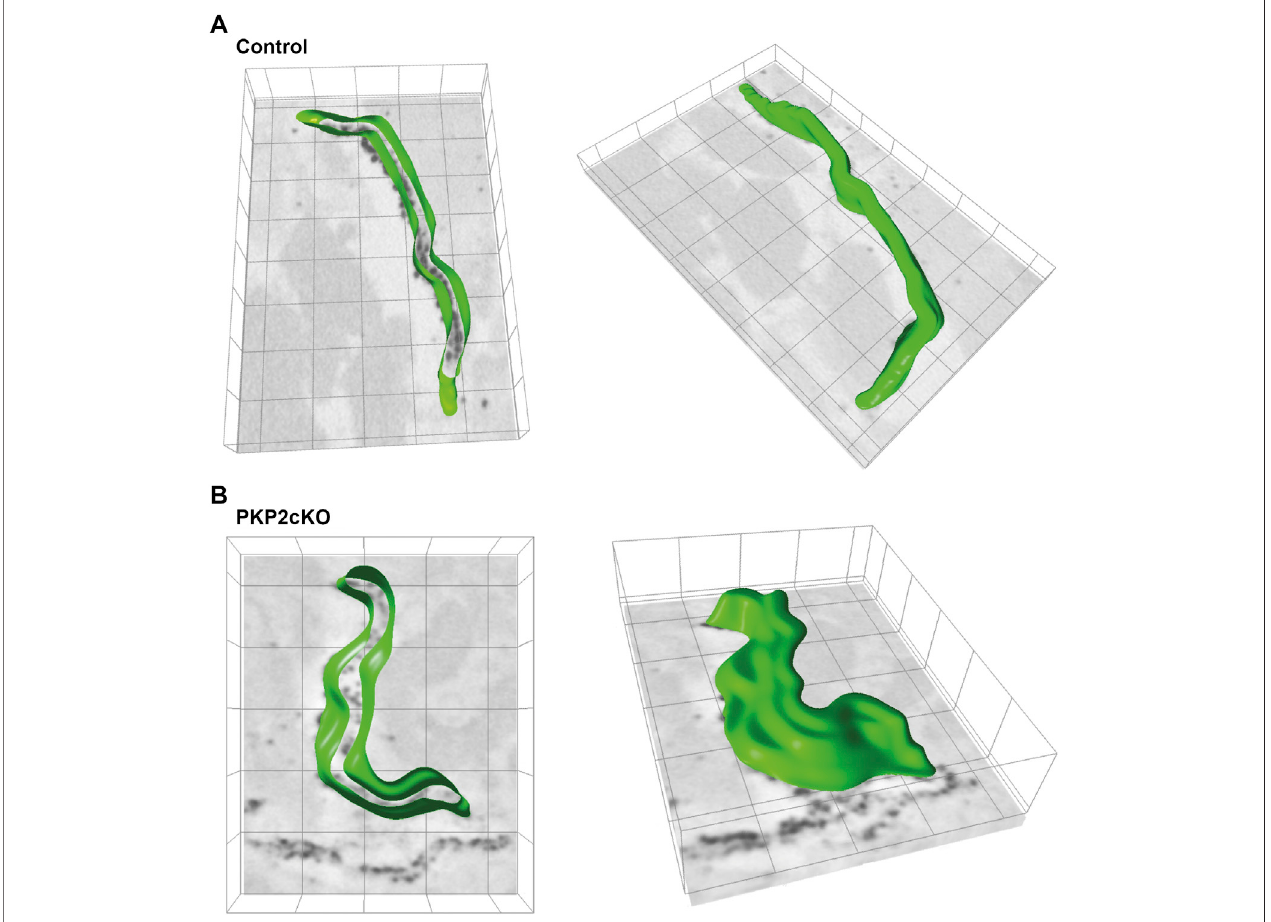
FIGURE 3 | 3D segmentation of the intercalated disc (ID) inner space in adult hearts of control and Plakophilin-2 conditional knock out mice (PKP2cKO). (A) Left panel : 3D segmentation, middle plane, of the inner space within the gap junction plaque of a control adult murine heart. The green line depicts Connexin43 immunoreactive beads segmented by ORS Dragon fl y software. Right panel : Top view of the ID inner space 3D segmentation, from the same control sample presented ontheleft. (B) Leftpanel :3Dsegmentation,middleplane,oftheinnerspacewithinthegapjunctionplaqueofaPKP2cKOadultmurineheart.Thegreenlinedepicts Connexin43 immunoreactive beads segmented by ORS Dragon fl y software. Right panel : Top view of the ID inner space 3D segmentation, from the same PKP2cKO sample presented on the left. Please note widening of the intercellular space and areas where single Connexin43 immunoreactive beads lack opposing beads in close proximity in the PKP2cKO